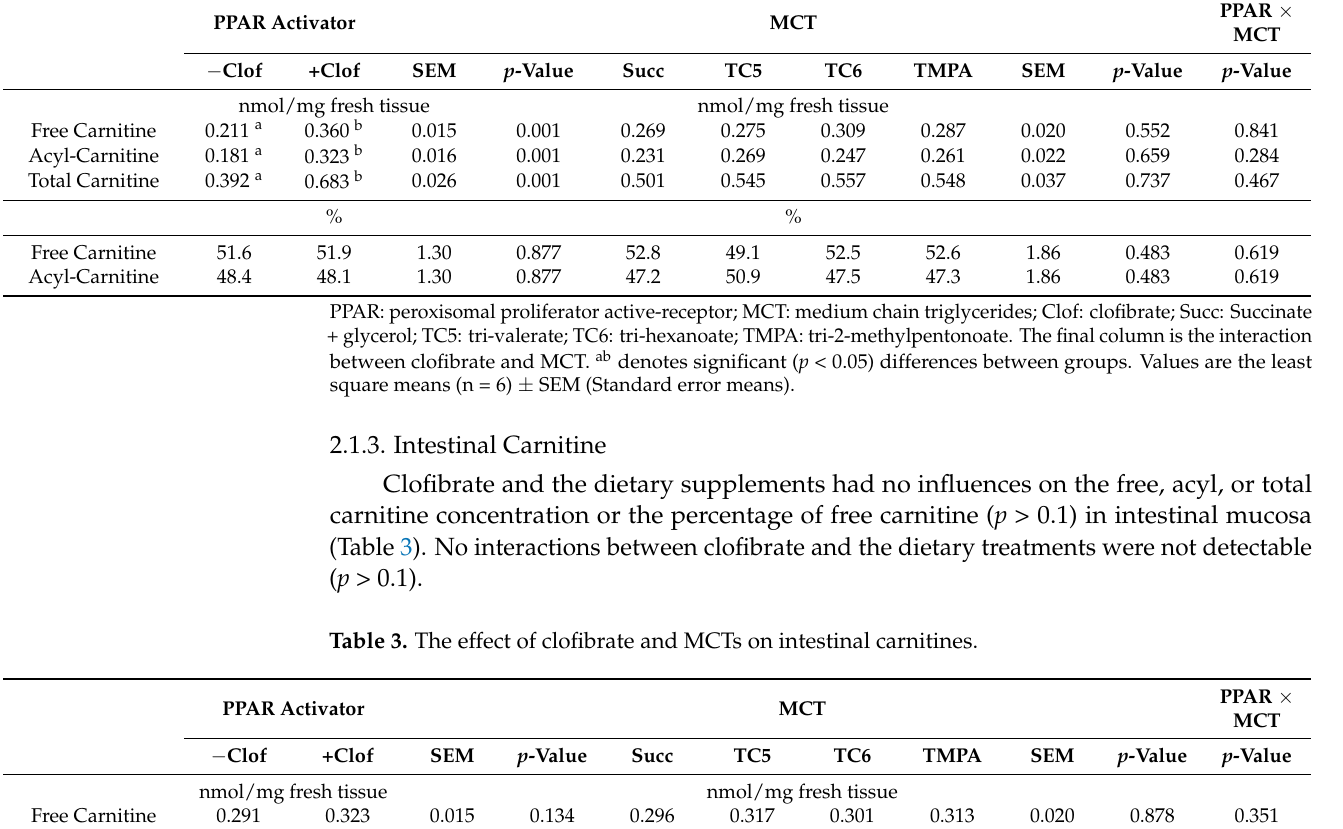
Table 2. The effect of clofibrate and MCTs on hepatic carnitines.